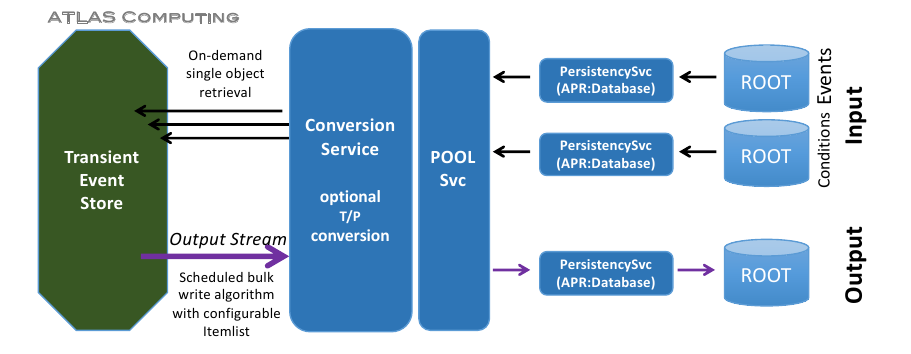
Figure 1. Basic components of the I / O services in Athena when reading and writing from ROOT files.